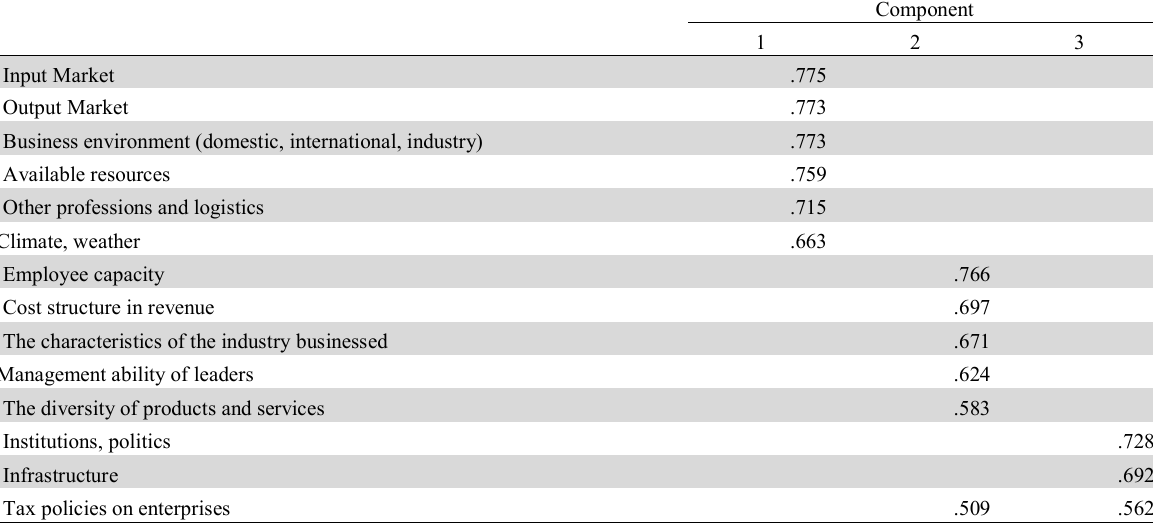
Matrix of factor rotation